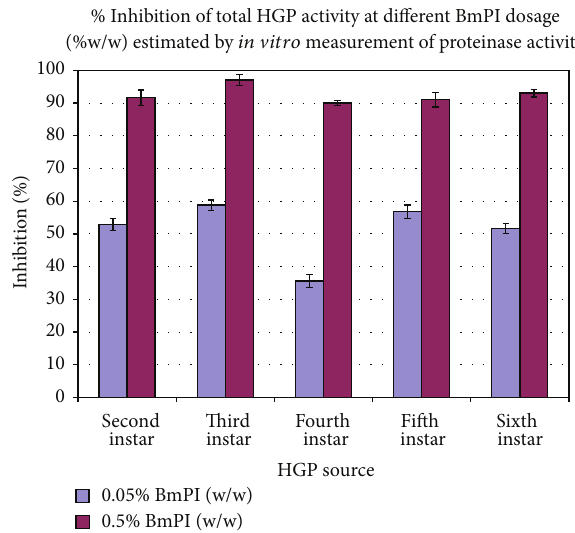
Figure 3: Prolonged treatment of larvae of second instar to sixth instar with two different concentrations of